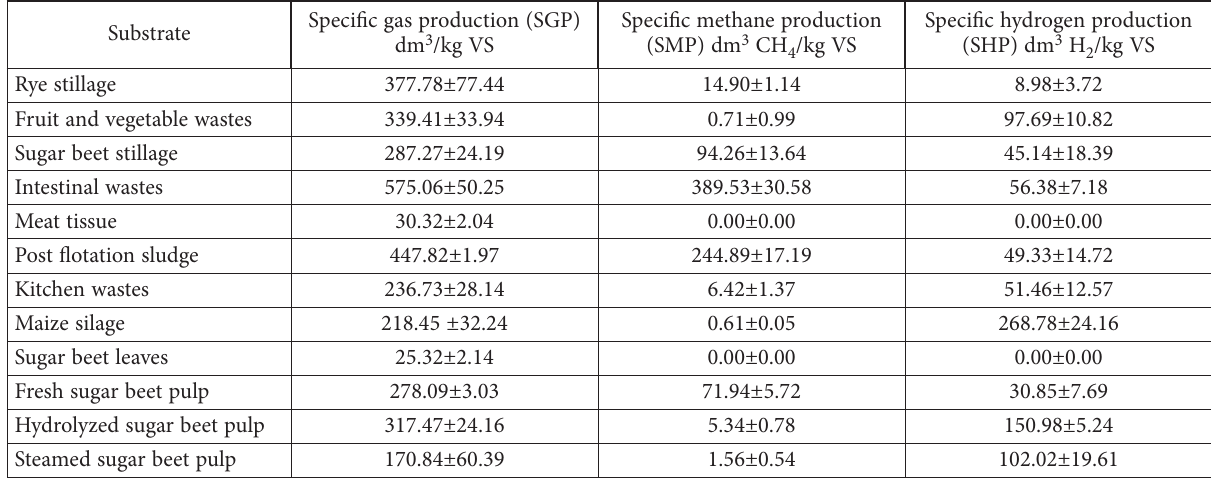
Table 5. Parameters of the batch digestion tests with thermal pretreatment